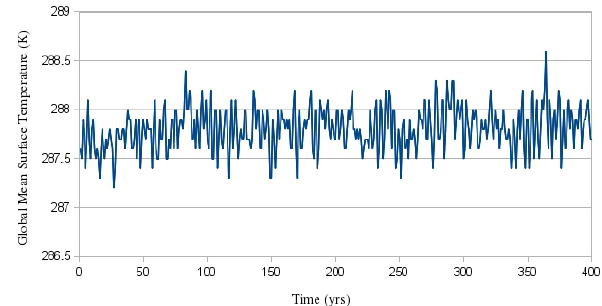
Figure 6. Global mean surface temperature (K), from a transient 400-year run with pre-industrial greenhouse gas concentrations (Exp. 2).